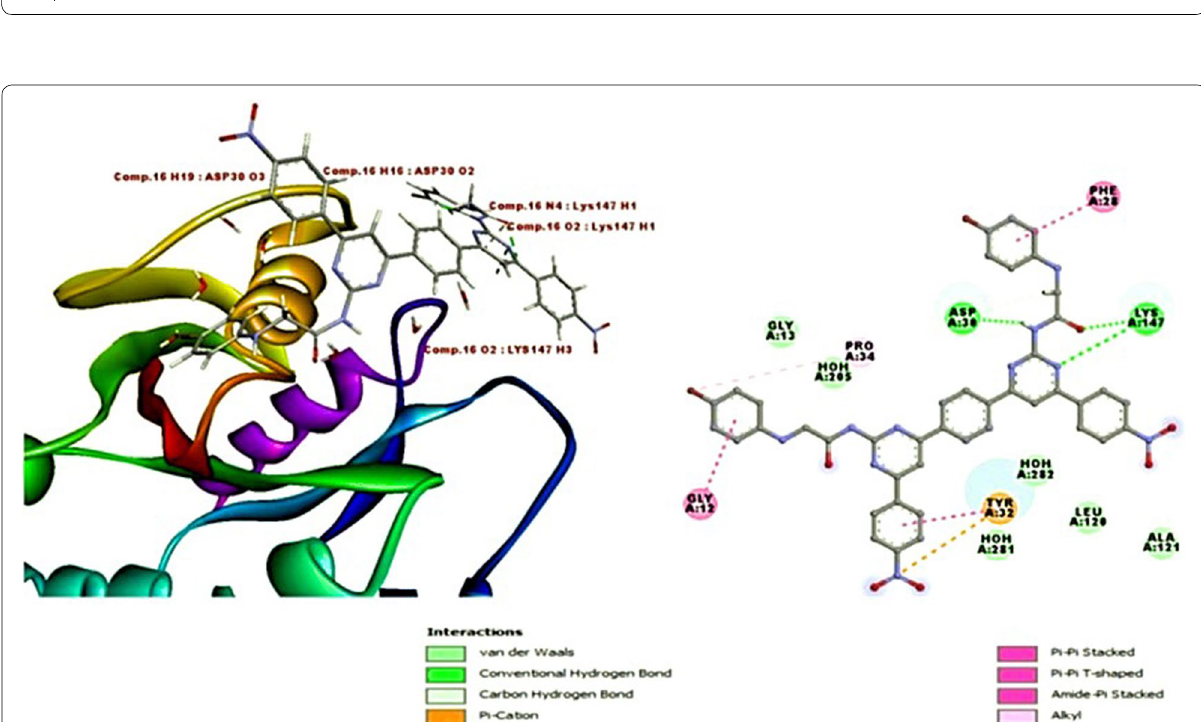
Fig. 2 Details of binding residues and orientation of compound 18 within the GTP binding pocket and secondary structural representation of compound 18